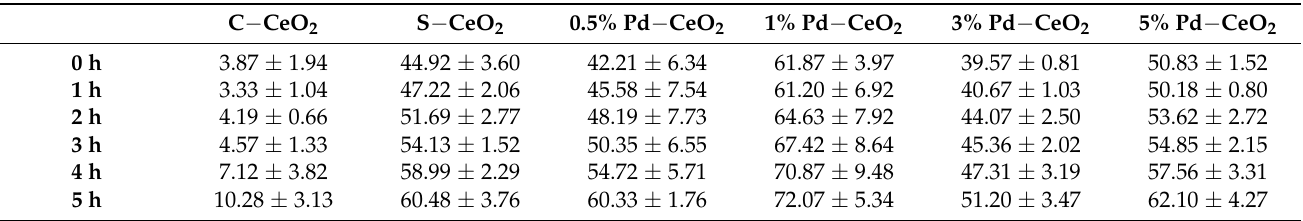
Table 4. The average percentage MB dye degradation using C − CeO 2 , S − CeO 2, and Pd − CeO 2 under visible light